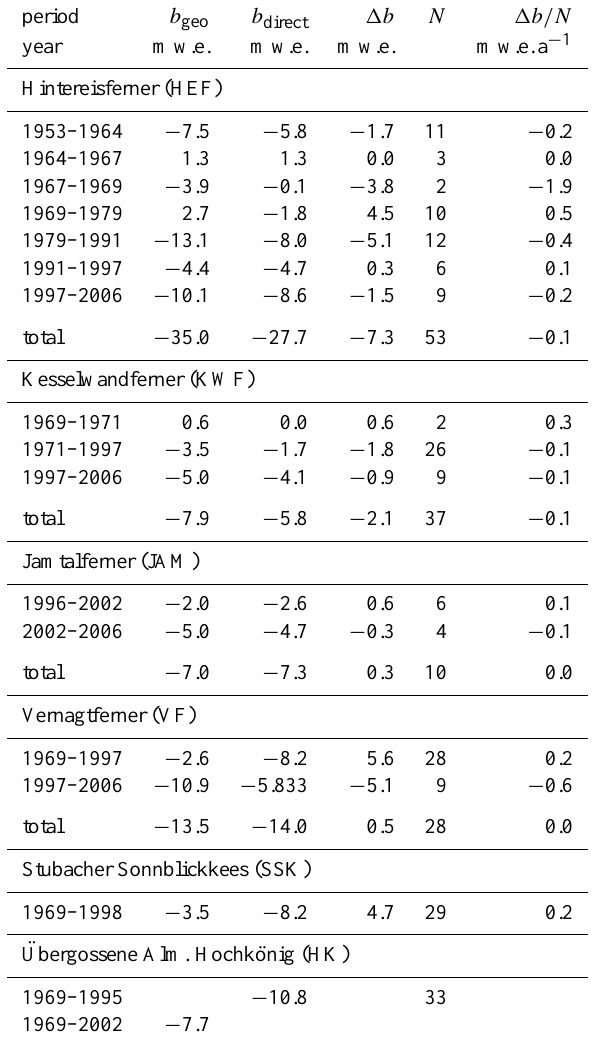
Table 3. Results of the cumulative specific mass balance for the geodetic b geo and the direct b direct method. The difference between the geodetic and the direct method is given in absolute numbers and divided by the number of years N . The numbers are rounded, the difference is calculated from the full values.